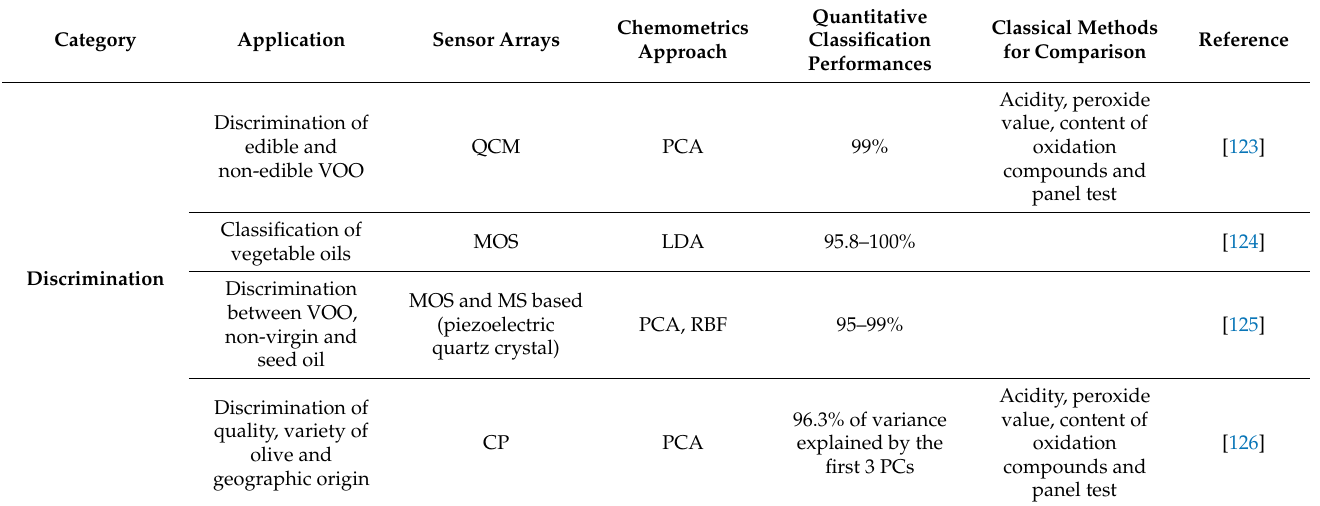
Table 4. Main applications of the electronic nose in the olive oil discrimination and